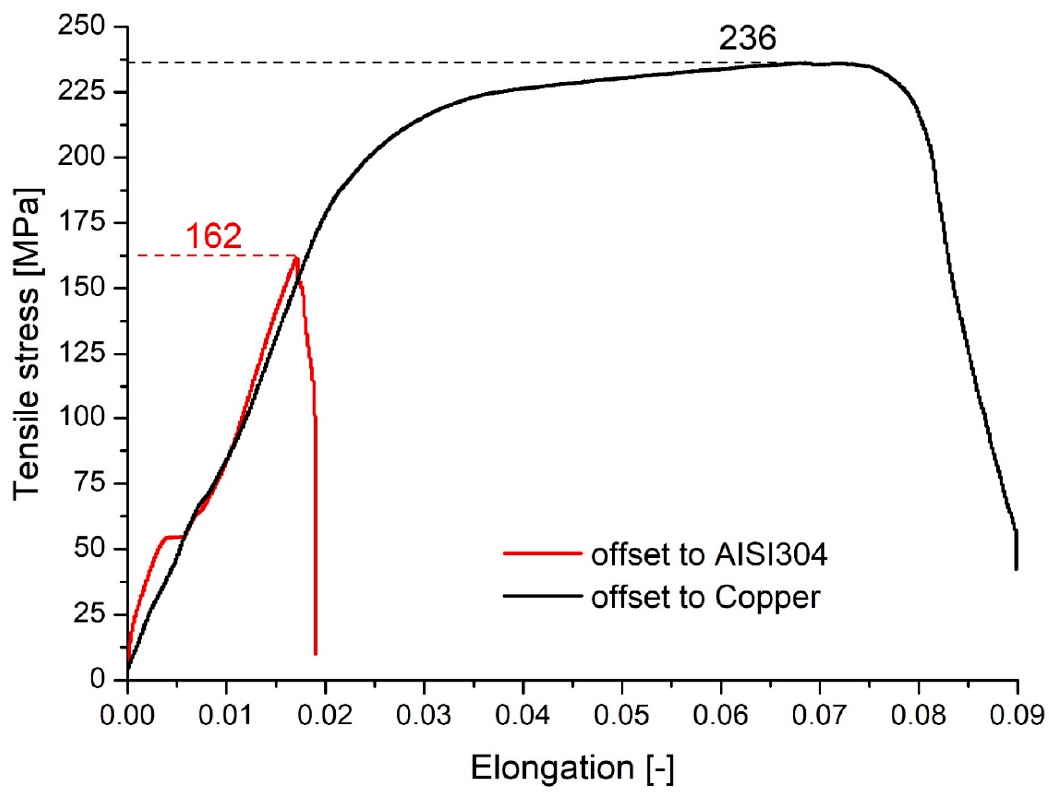
Figure 13. Stress-strain curves for welded joints Nos. 1 and 5.